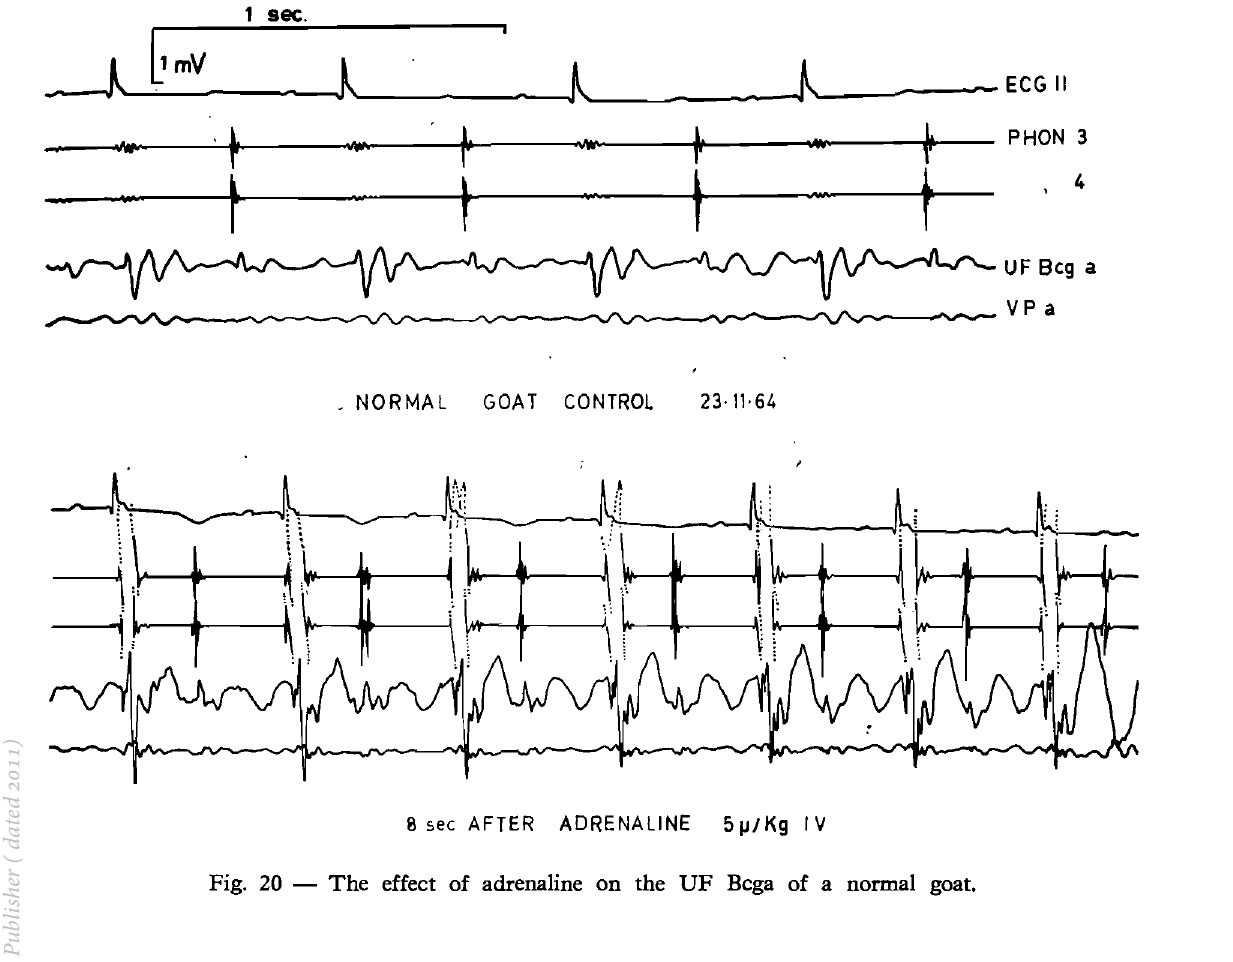
Fig. 20 - The effect of adrenaline on the UF Bcga of a normal